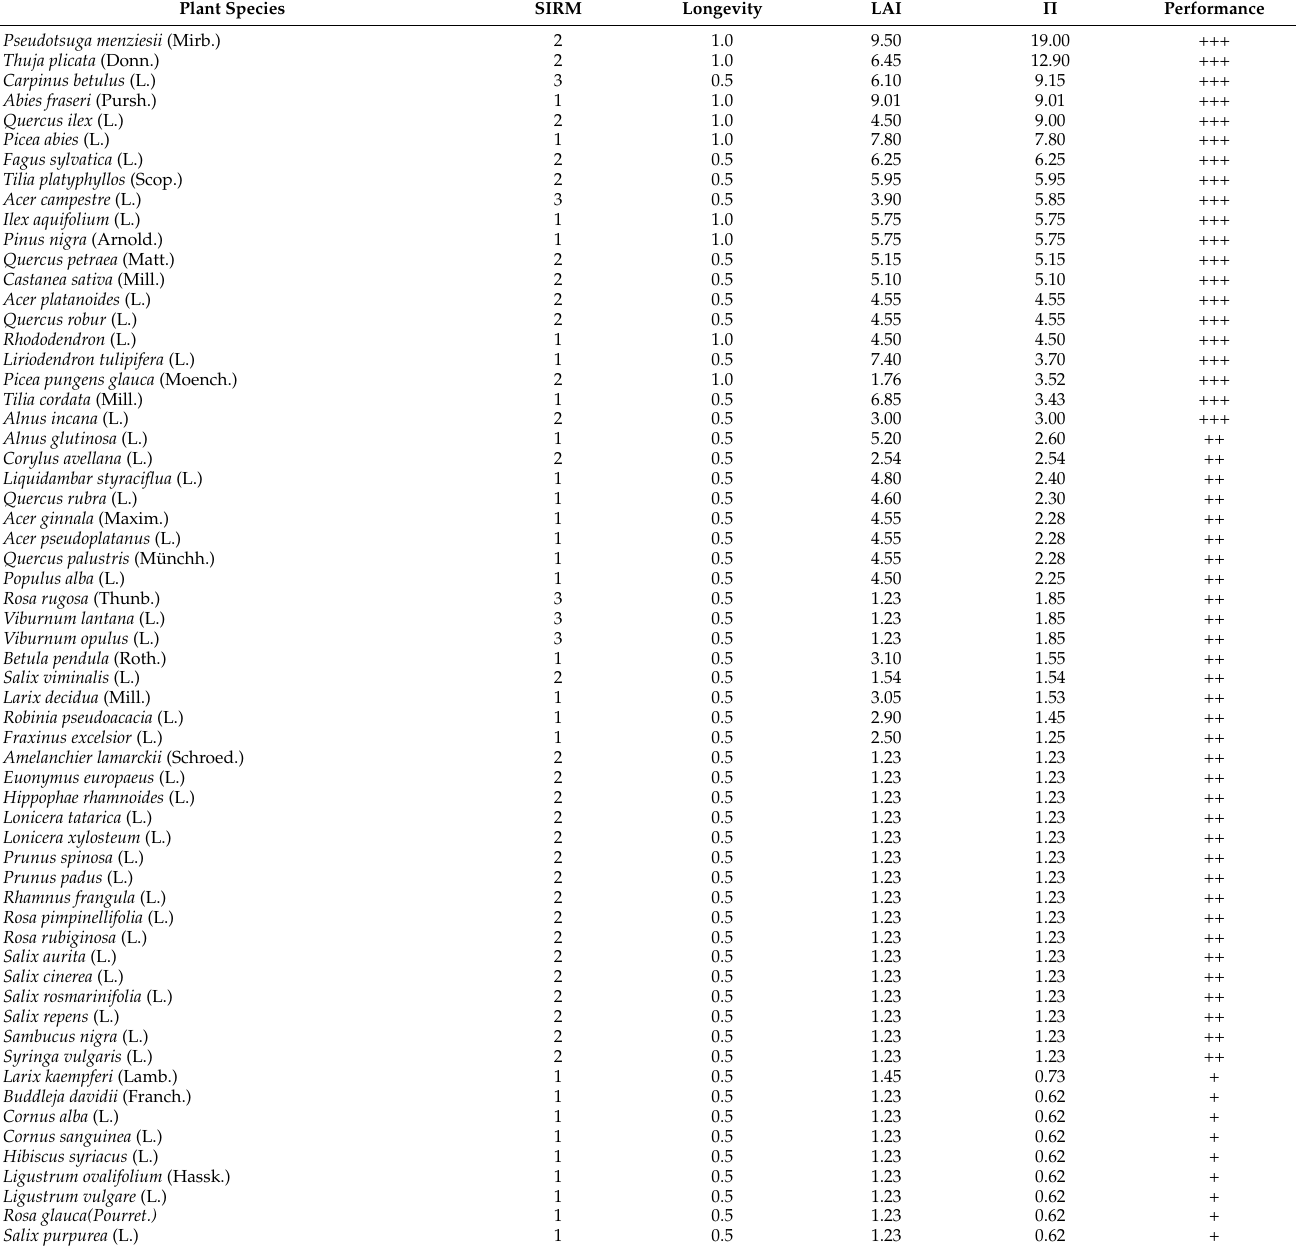
Table 4. Leaf SIRM model with the assignment of scores (1-3) for leaf SIRM ( µ A) values based on measurements conducted in September 2016 and classified into three groups based on Jenks natural breaks classification. The leaf longevity: i.e., evergreen needle/scale-like/broadleaf (assigned a value of 1) or deciduous broadleaf/needle-like (assigned a value of 0.5). The values for leaf area index (LAI m 2 m − 2 ) are obtained from the literature. Π is the product of leaf SIRM score, leaf longevity values, and LAI. The plant species are grouped into three classes based on quantile classification indicating their performance as high (+++), moderate (++), and low (+). Plant species are shown in descending order based on their performance